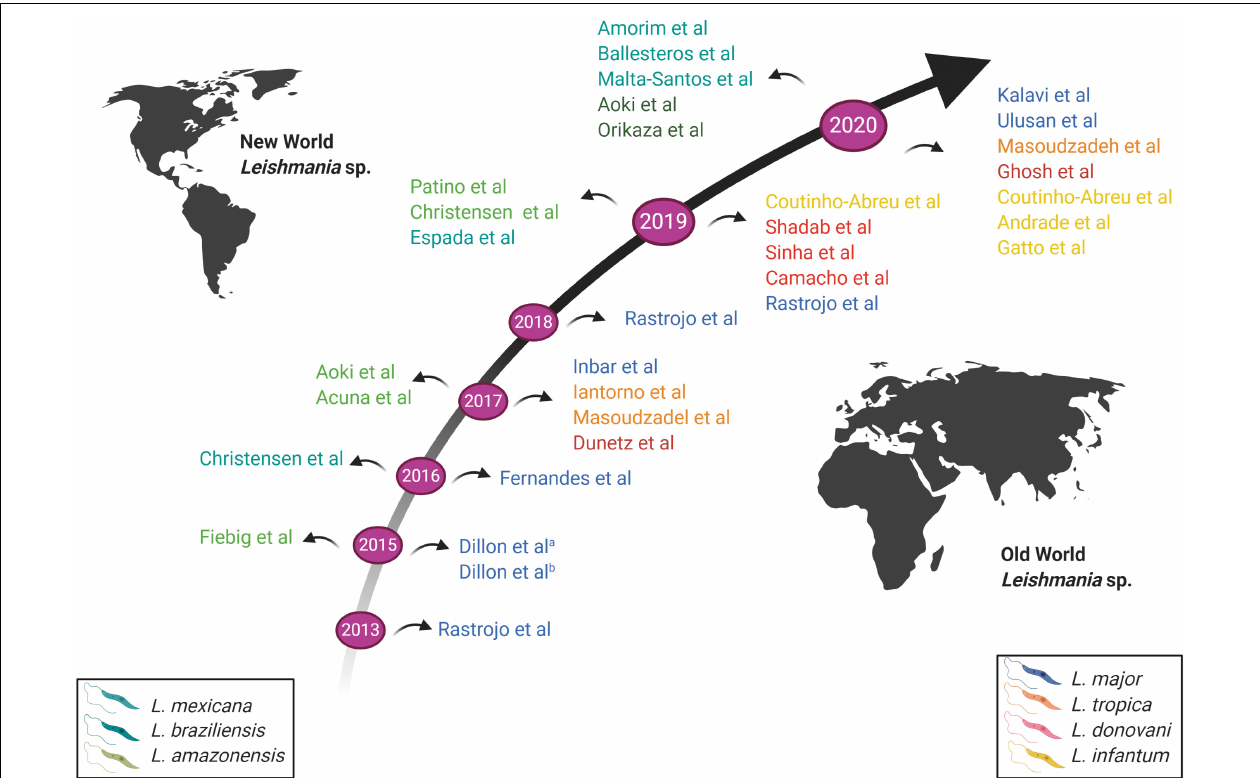
FIGURE 3 | Schematic representation of the time-based evolution of RNA-seq conducted on Leishmania parasites. Studies above the arrow represent RNA-Seq conducted on New World Leishmania species; studies below the arrow represent RNA-Seq conducted on Old World Leishmania species. The various Leishmania species studied are indicated by different colors, as shown in the legend. New World Leishmania species are shown on the left; Old World Leishmania species are shown on the right. Image created with